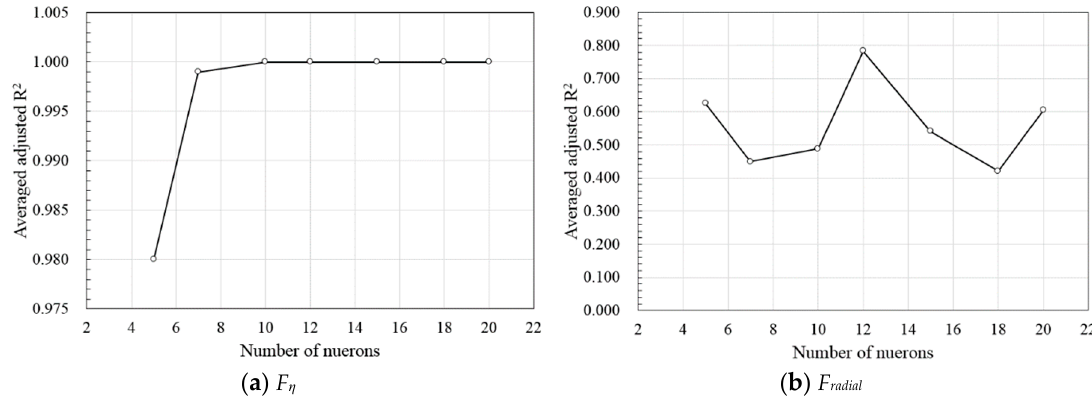
Figure 8. Comparison of averaged adjusted R 2 of RBNN.